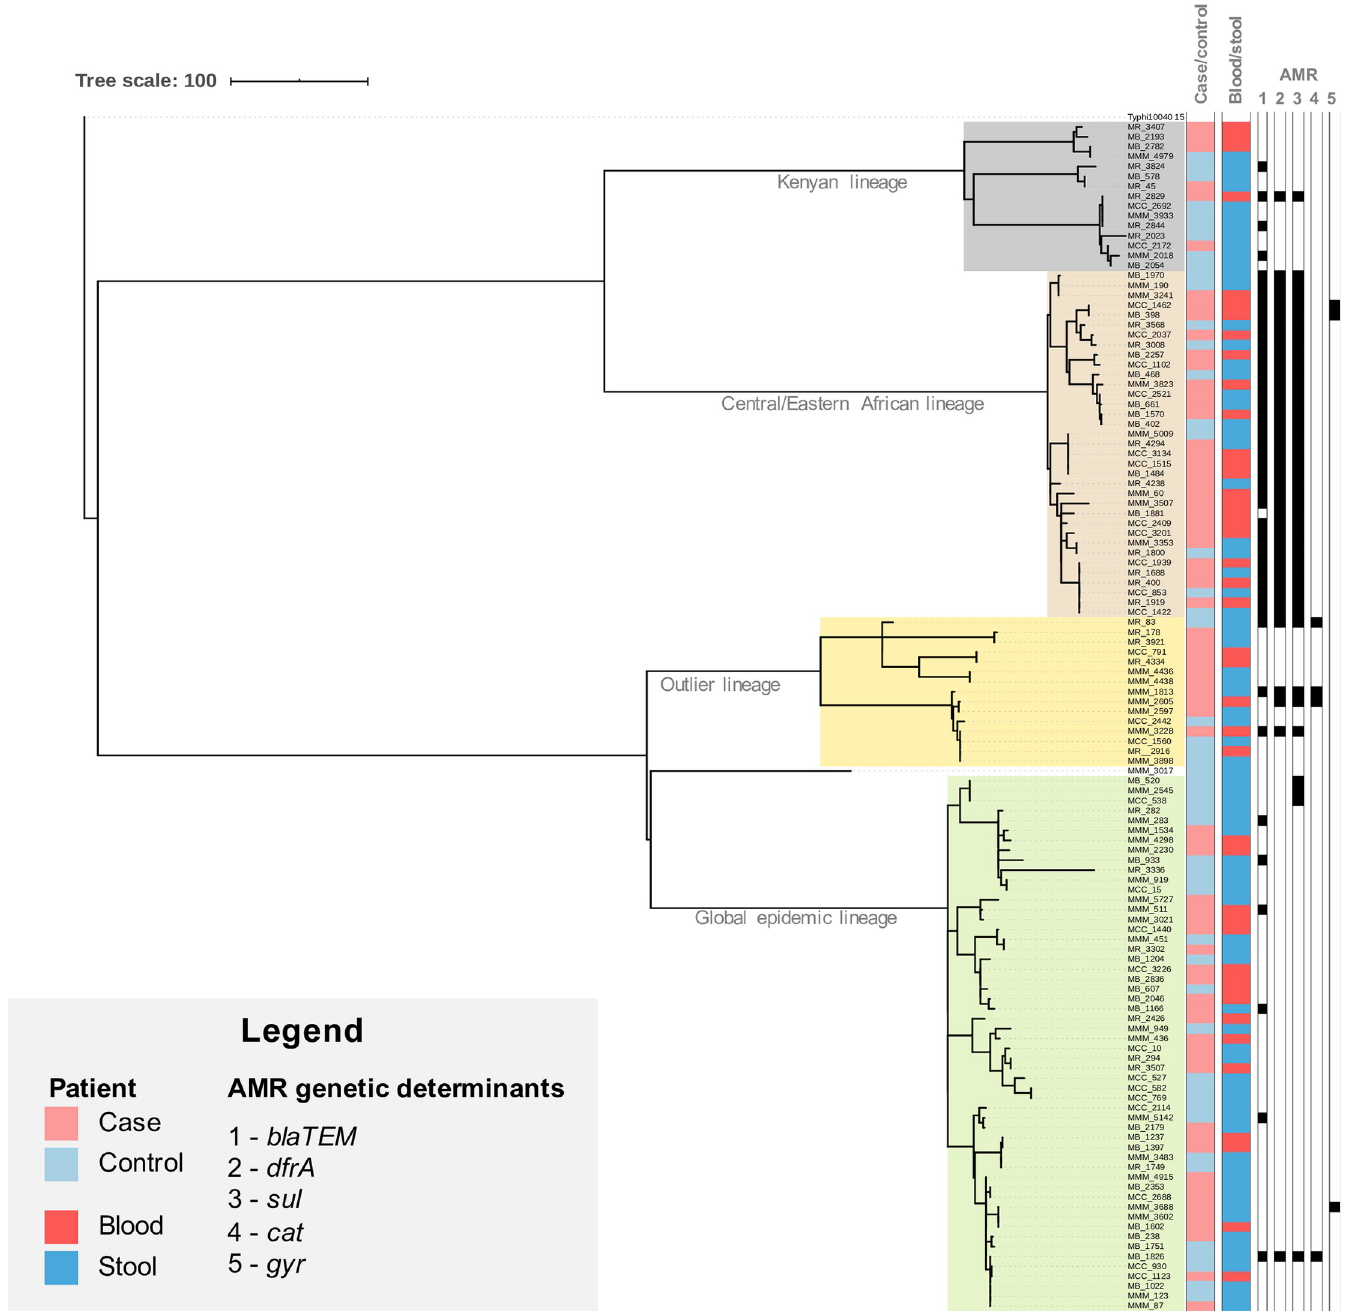
Fig 3. Phylogenetic tree of S . Enteritidis isolates from this study. Maximum likelihood phylogenetic tree based on the 120 S . Enteritidis genome sequences from this study. Sequencing reads were mapped against S . Enteritidis reference strain P125109, and S . Typhi 10040_15 was added as an outgroup to root the tree. The tree is based on 60302 chromosomal SNPs. Patient state (case/control) and the source (blood/stool) is visualized as indicated in the legend. Presence of multidrug resistance markers (MDR; bla , dfrA , sul , cat ) and SNPs in gyr are annotated. Branch lengths represent numbers of SNPs as indicated in the scale